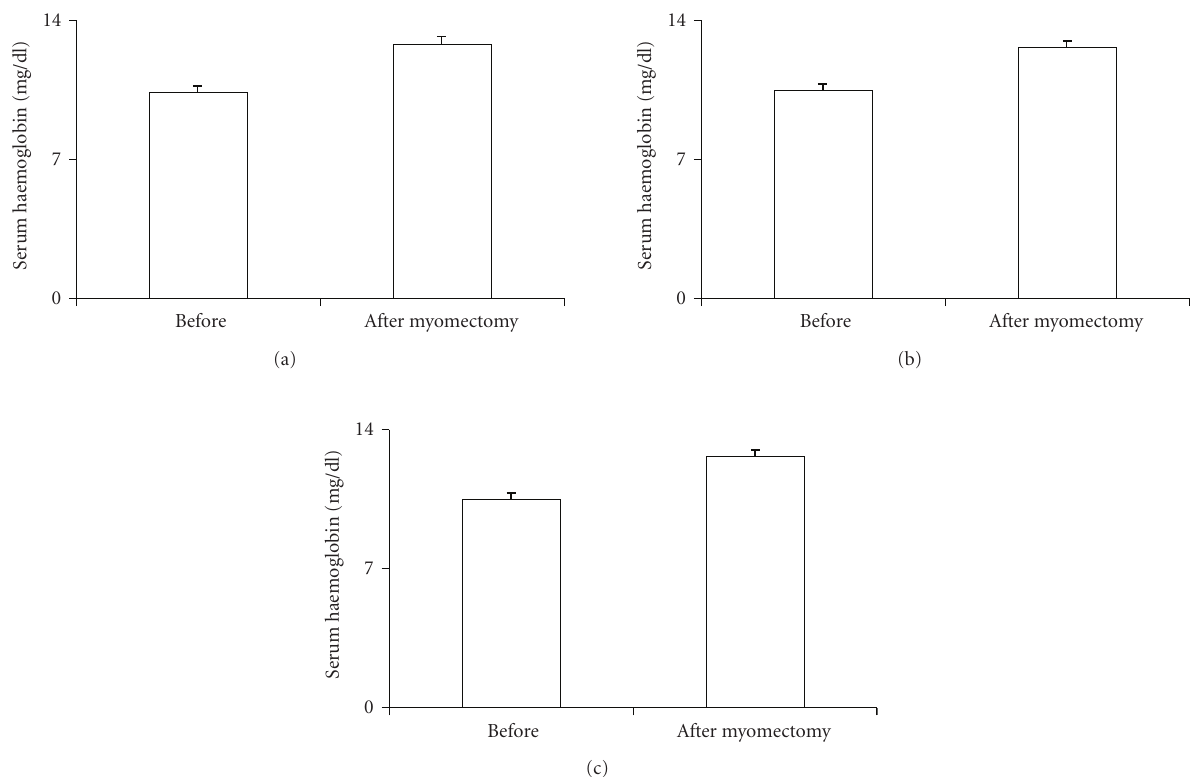
Figure 1: Serum haemoglobin concentration after treatment in the three groups. Group 1: women treated with 15 mcg of ethynilestradiol + 60mcg of gestodene; group 2: women treated with 20 mcg of ethynilestradiol + 100mcg of levonorgestrel; group 3: women treated with a placebo. ∗ = P < .